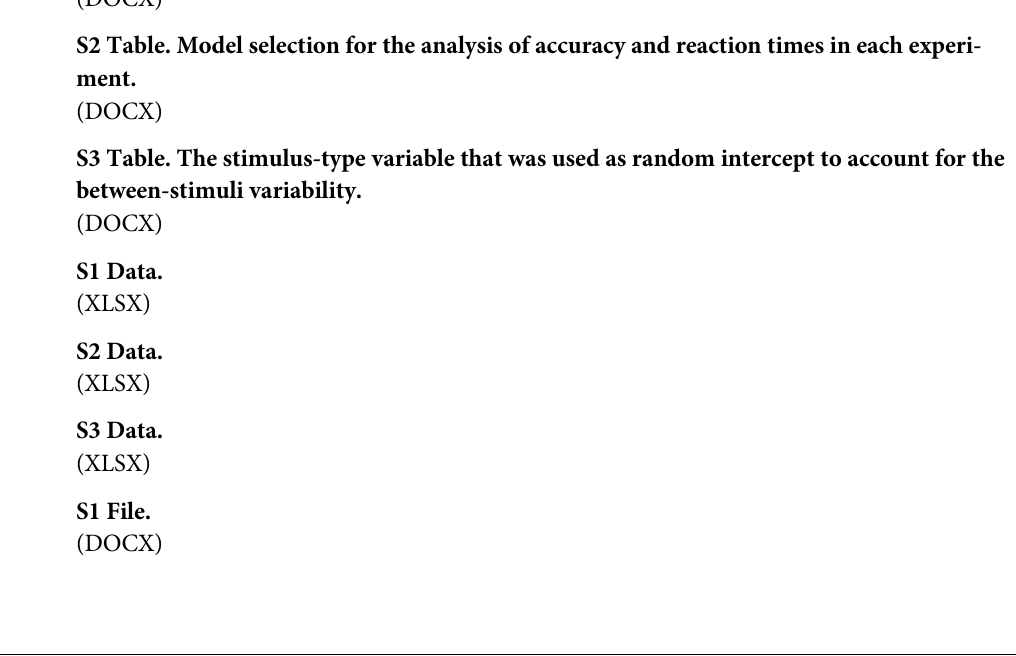
S1 Table. Average response times and accuracy per stimulus at the Go/No-Go task. S2 Table. Model selection for the analysis of accuracy and reaction times in each experi- ment. S3 Table. The stimulus-type variable that was used as random intercept to account for the between-stimuli